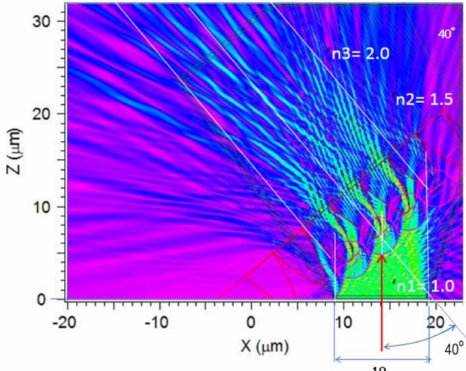
Figure 3. The position of LED light seen from the back of the screen being ~15 mm apart from the paraboloids sheet of PDC, behind which the LED is set with various incident angle θ with respect to the PDC. The arrows show the center of the incident LED light beam.